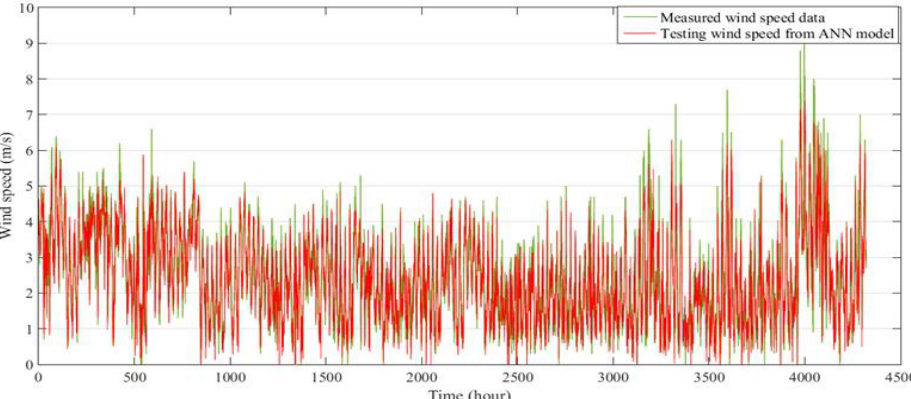
Figure 15. Comparison between measured and predicted hourly wind speed data for six months at Kudat, for validation of the ANN model.